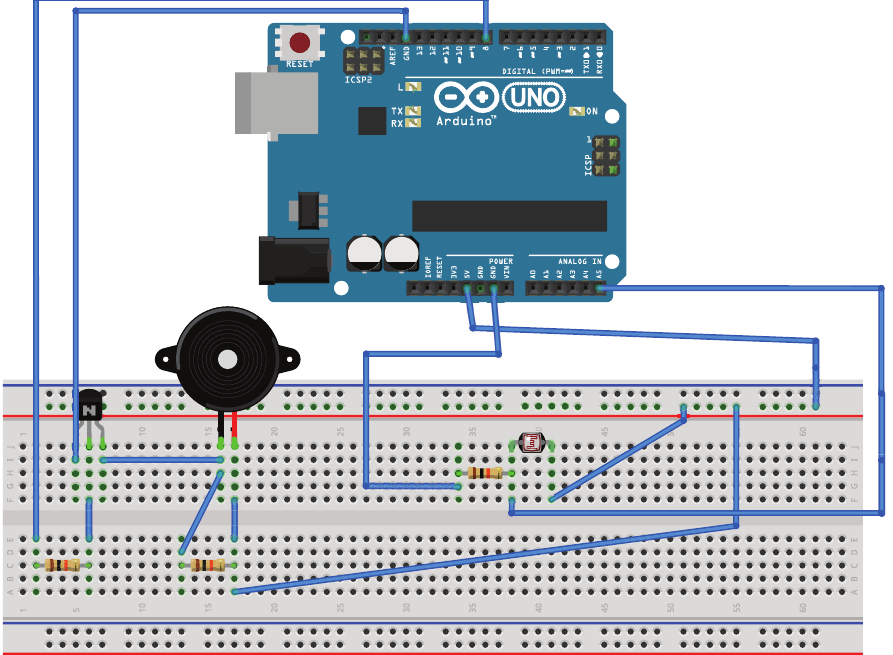
Figure 7. The scheme of laboratory model of fire